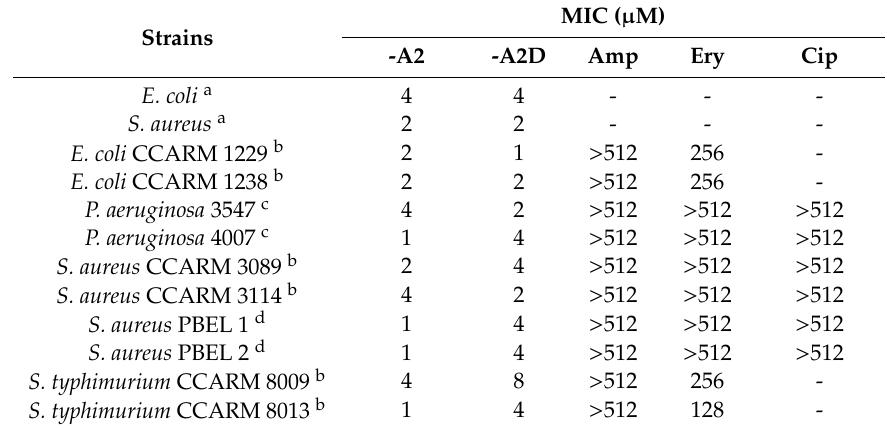
Figure 6. HPA3NT2-A2D peptide does not induce resistance. Induction of resistance to antimicrobial peptide and conventional antibiotic drug in S. aureus ATCC 25923. The Y -axis is the relative change in the MIC from the first passage. Error bars indicate SD ( p < 0.005). Table 3. Antimicrobial activity of HPA3NT3-A2, HPA3NT3-A2D, antibiotics against drug-resistant bacterial strains.